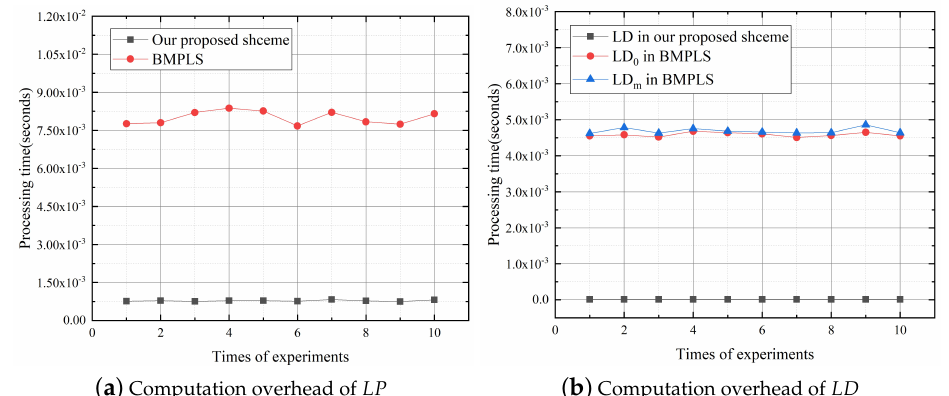
Figure 11. Computation overhead in the location update.